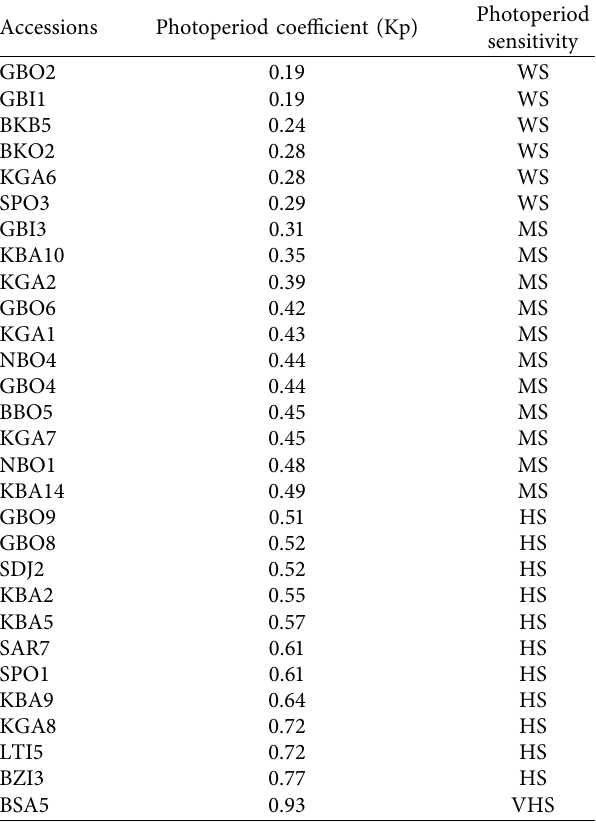
Table 5: Photoperiod coefficient values of sweet sorghum accessions.